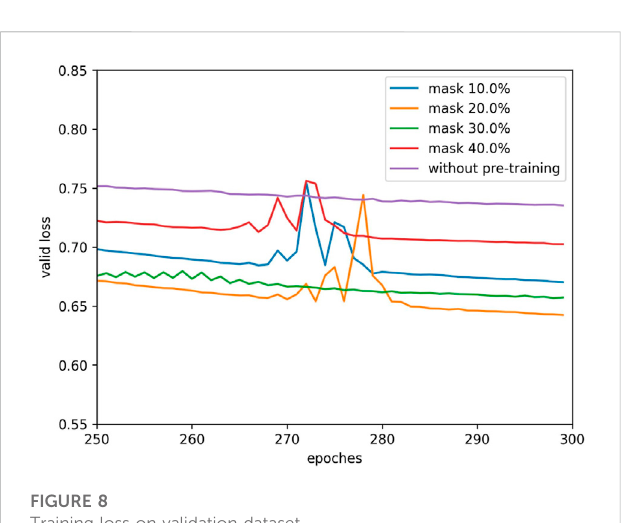
FIGURE 8 Training loss on validation dataset.